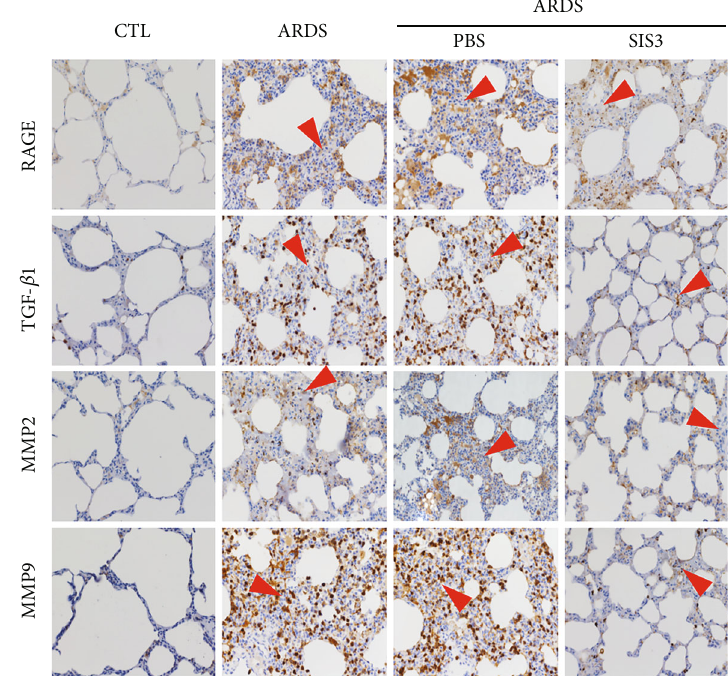
Figure 2: SIS3 pretreatment decreases the protein expression and localization of RAGE, TGF- β 1, MMP2, and MMP9 in ARDS rats. Immunohistochemical staining of lung tissue sections showed that RAGE, TGF- β 1, MMP2, and MMP9 were expressed in the bronchial smooth muscle, airways, and alveolar epithelial cells of rats. The expression levels of RAGE, TGF- β 1, MMP2, and MMP9 in the ECM of ARDS rats induced by LPS were signi fi cantly higher than those of the control group. RAGE, TGF- β 1, MMP2, and MMP9 were reduced by pretreatment with SIS3, and no e ff ect was found upon pretreatment with PBS. The micrographs were magni fi ed at 400x. The red triangles indicate in fi ltrated